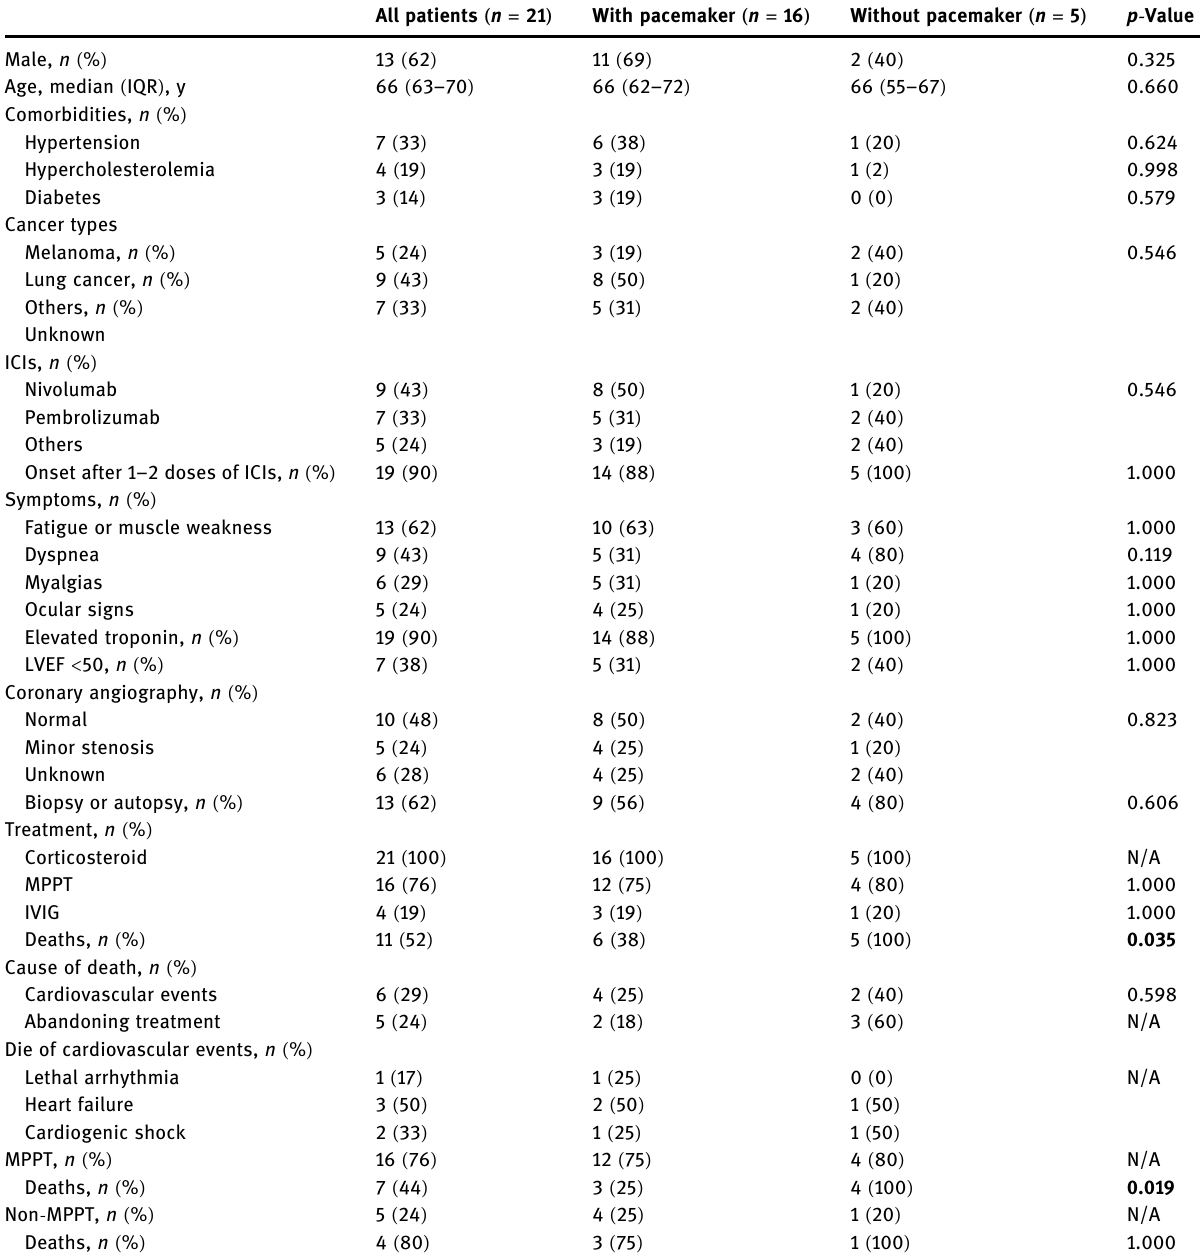
Table 1: Characteristics of patients with immune - related myocarditis concomitant with CHB All patients ( n = 21